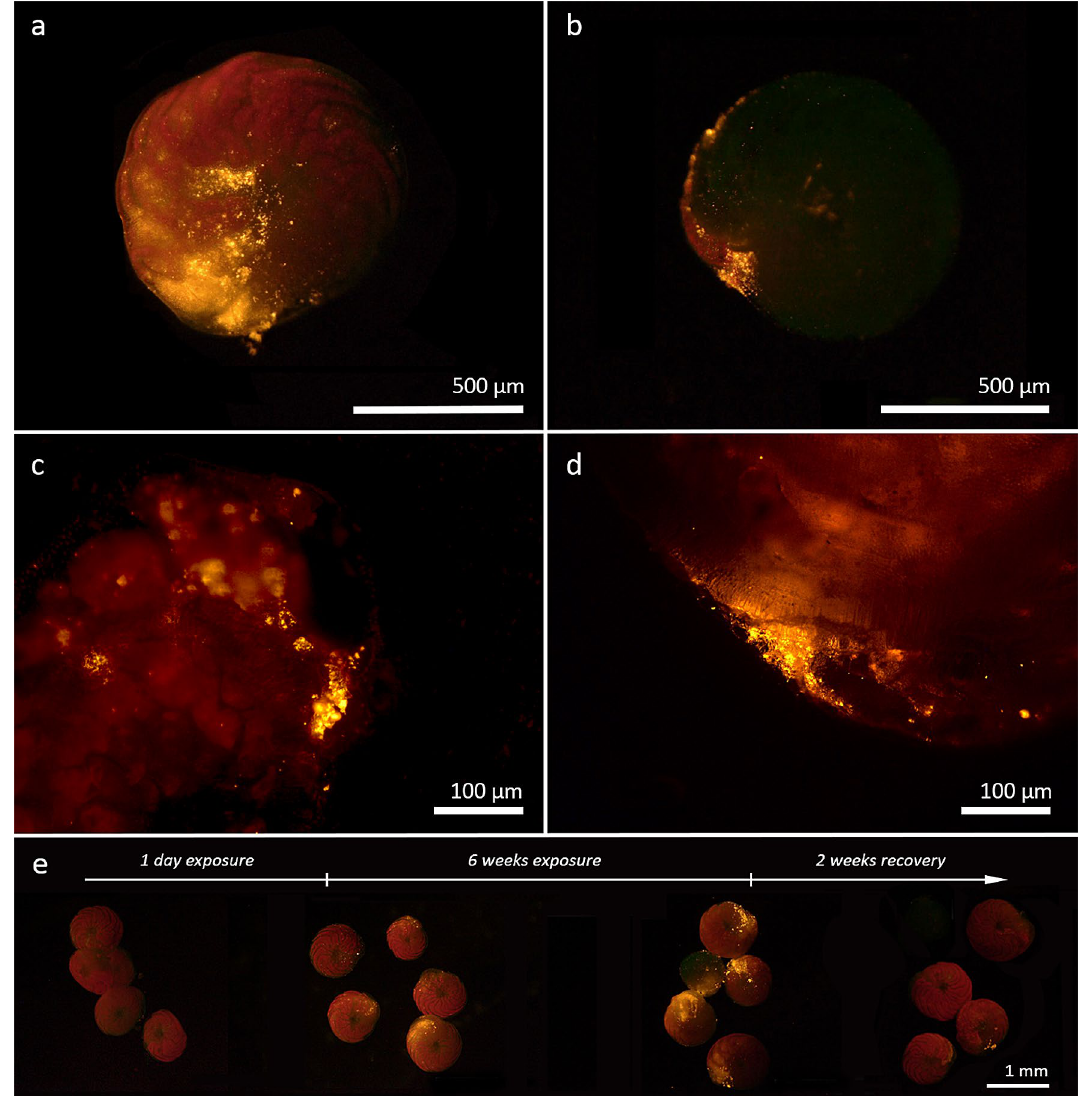
Figure 2. Examples showing cases of nanoplastic uptake and incorporation by fluorescence microscopy. ( a ) LBF seen here with ingested nanoplastic fluorescing yellow. ( b ) LBF with nanoplastic located only in the most recently formed chamber and at the aperture. Images ( c ) and ( d ) show sections of the foraminiferal tests with a view into the calcified test walls, providing closeups of the incorporation site. Pictures ( b ) and ( d ) show the same LBF individual from the ventral and dorsal side. ( e ) Timeline of nanoplastic ingestion in one exemplary replicate. Prior to nanoplastic exposure, five healthy LBF specimens show red fluorescence due to the autofluorescence of LBF symbionts. After 1 day of exposure, the uptake of yellow fluorescent nanoplastic is visible. Uptake of nanoplastic increased after 6 weeks of exposure and the loss of red fluorescence (resulting in a loss of symbiont fluorescence) is visible in one specimen. After the 2-week recovery period, four of the LBF had successfully egested all nanoplastic inside their cytoplasm, with one bleached during the egestion period (and thus not visible under fluorescent light). Only one of the specimens had nanoplastic remaining in its first (47.0 ± 5.5% LBF, n = 160). While LBF seemed to efficiently egest those particles from their inner cytoplasm, they appear to have stuck to the outer primary organic layer present at the sites of calcification 29,35,36 and were thus passively incorporated in the calcite test. The calcite overgrowth on nanoplastic particles appears as calcite crusts, likely precipitated in the process of chamber wall thickening or new chamber formation 35,37 (Fig. 1e). Previous studies document Amphistegina cal- cification mechanisms through the initial formation of calcite spheres that subsequently are bound by an organic matrix (seen as organic filaments) to form a primary wall structure 35 . Although these calcite spheres are slightly larger 35 (~ 2–3 μm) than the nanoplastic spheres used in this study, similar organic filaments were observed spanning across multiple nanoplastic particles. This indicates that nanoplastic spheres could be perceived by the LBF as potential ‘building-material’ for a newly forming chamber or during localized repair processes. The